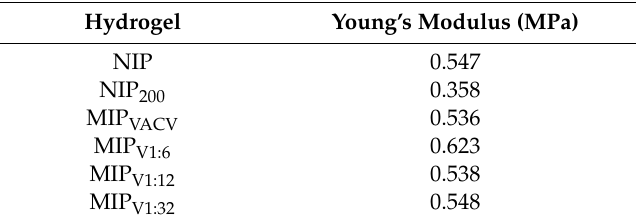
Table 2. Elastic properties of the hydrogels.